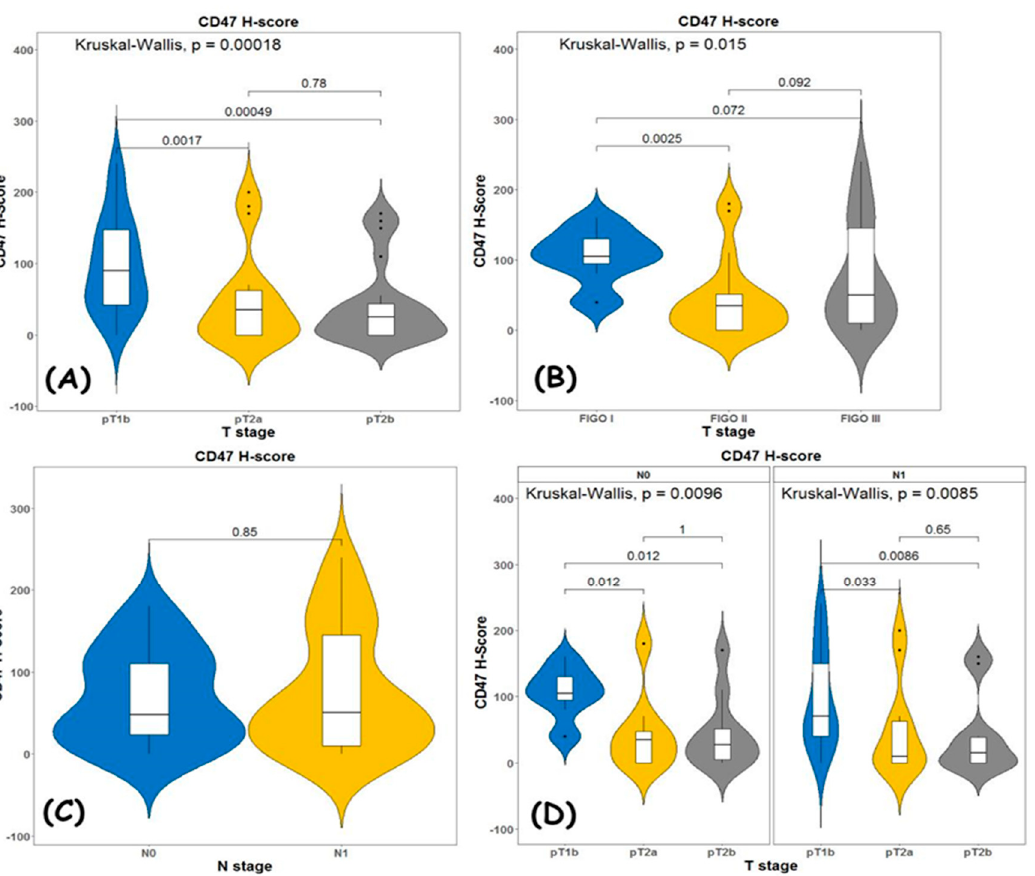
Figure 3. Kruskal–Wallis test for association between ( A ) TNM T stage and H-score; ( B ) FIGO stage and H-score; ( C ) N status and H-score and ( D ) T stage and H-score in node negative and node positive patients.